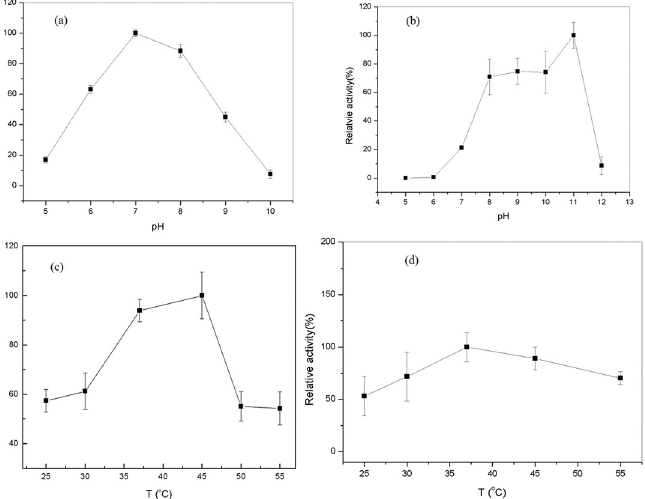
Fig 8. Effects of pH and temperature on the activities of the GDH-NOX. (a) optimal pH of NOX in GDH-NOX complex. (b) The optimal pH of GDH in GDH-NOX complex. (c) Optimal temperature for the GDH in the GDH-NOX complex. (d) Optimal temperature for the NOX in the GDH-NOX complex. NOX activity was tested with 0.2 mM NADH, 100 μ L buffers with different pH. GDH activity was determined under the